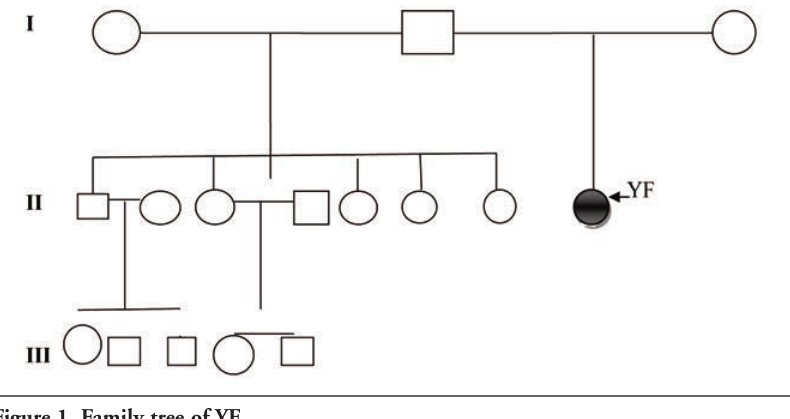
Figure 1. Family tree of YF.